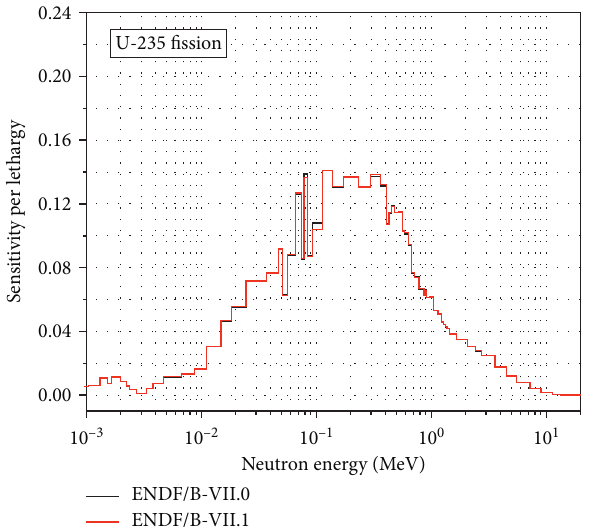
Figure 6: Energy-dependent sensitivities of k cross section.